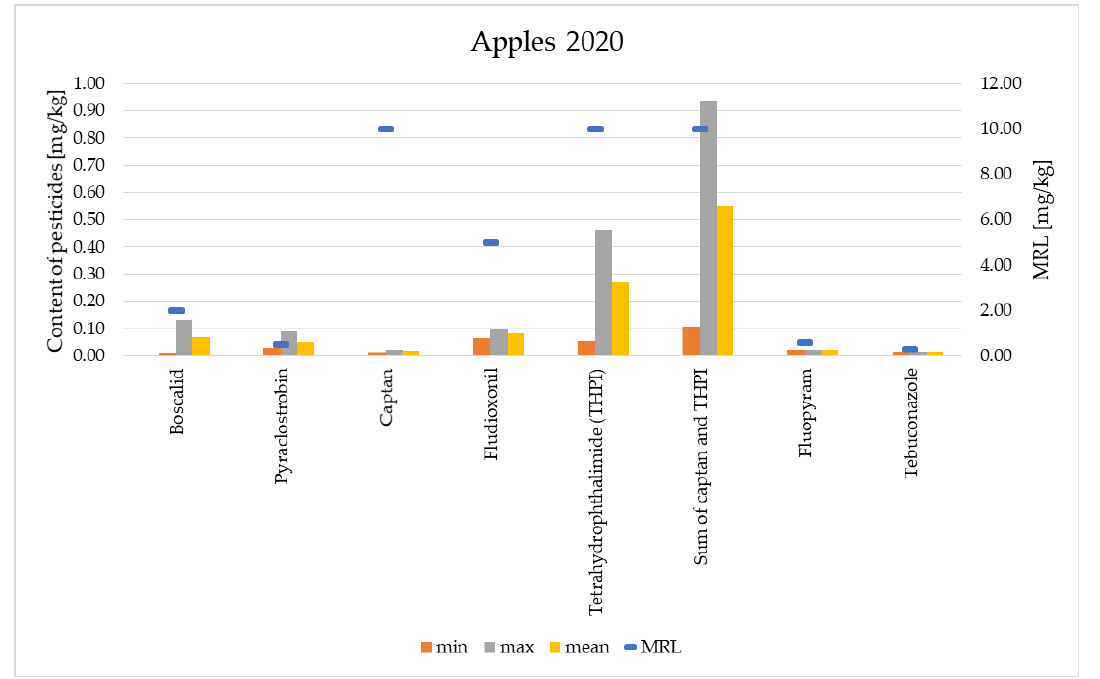
Figure 2. Content of pesticides in samples of whole apples from the harvest of 2020.